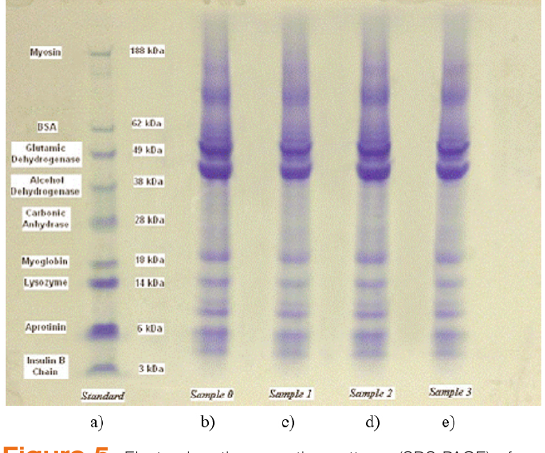
Figure 5. Electrophoretic separation patterns (SDS-PAGE) of wool samples: a) standard, b) untreated, c) dyed at 98°C without enzyme, d) dyed at 85°C without enzyme, e) dyed at 85°C with enzyme.